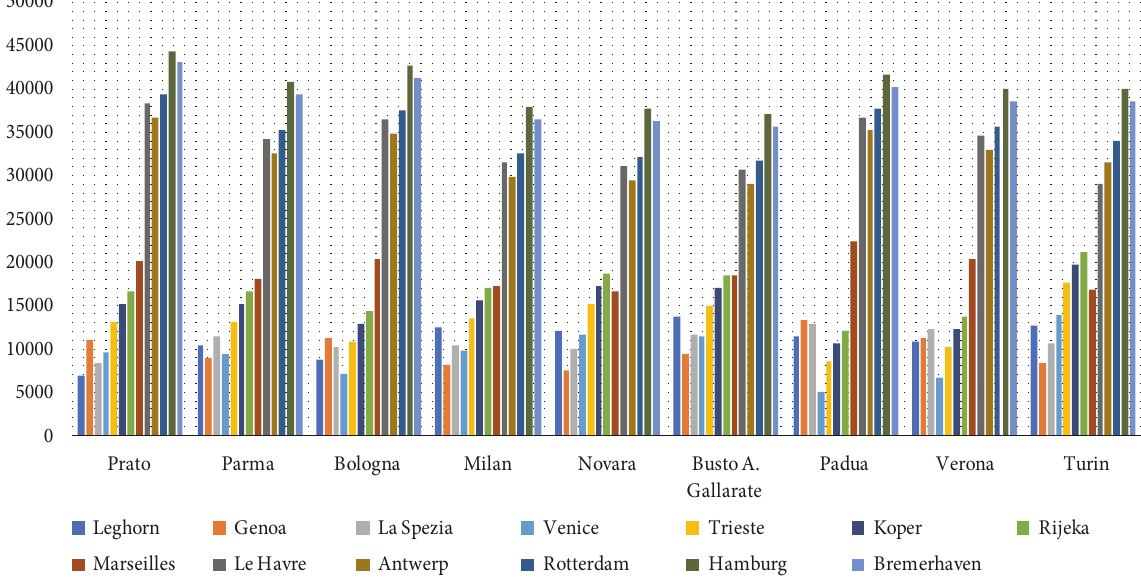
Figure 5: Generalised costs of a full train (€) from the ports considered in the analysis, towards Italian destinations. Optimisation by generalised costs.